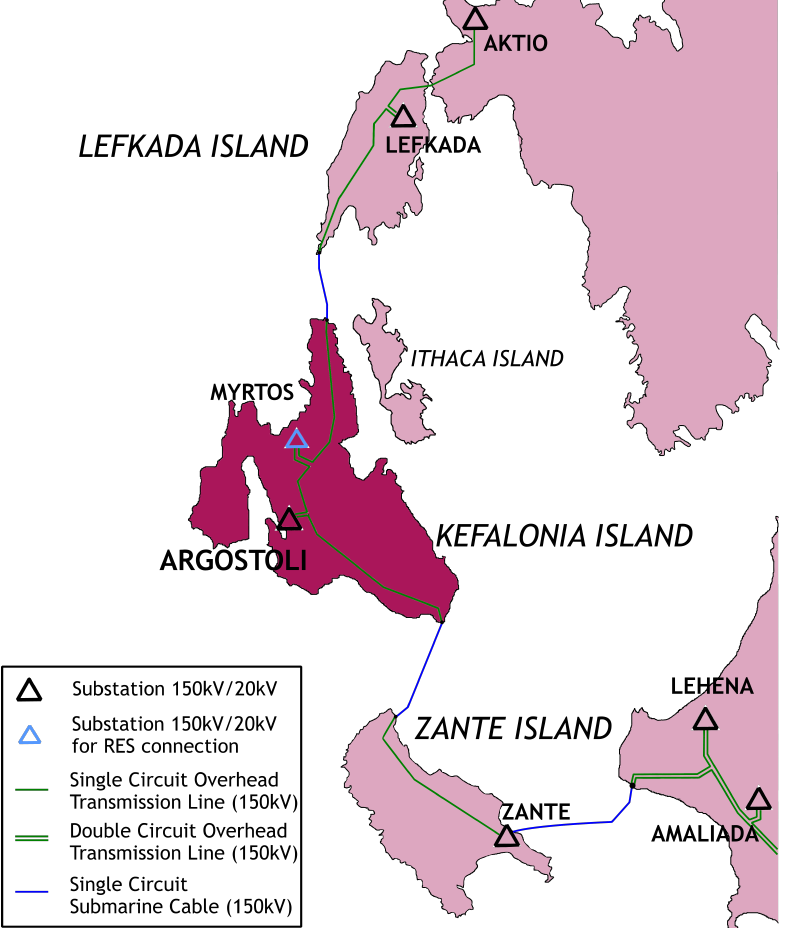
Figure 5. Map of the TS in the broader area of Argostoli HV Substation